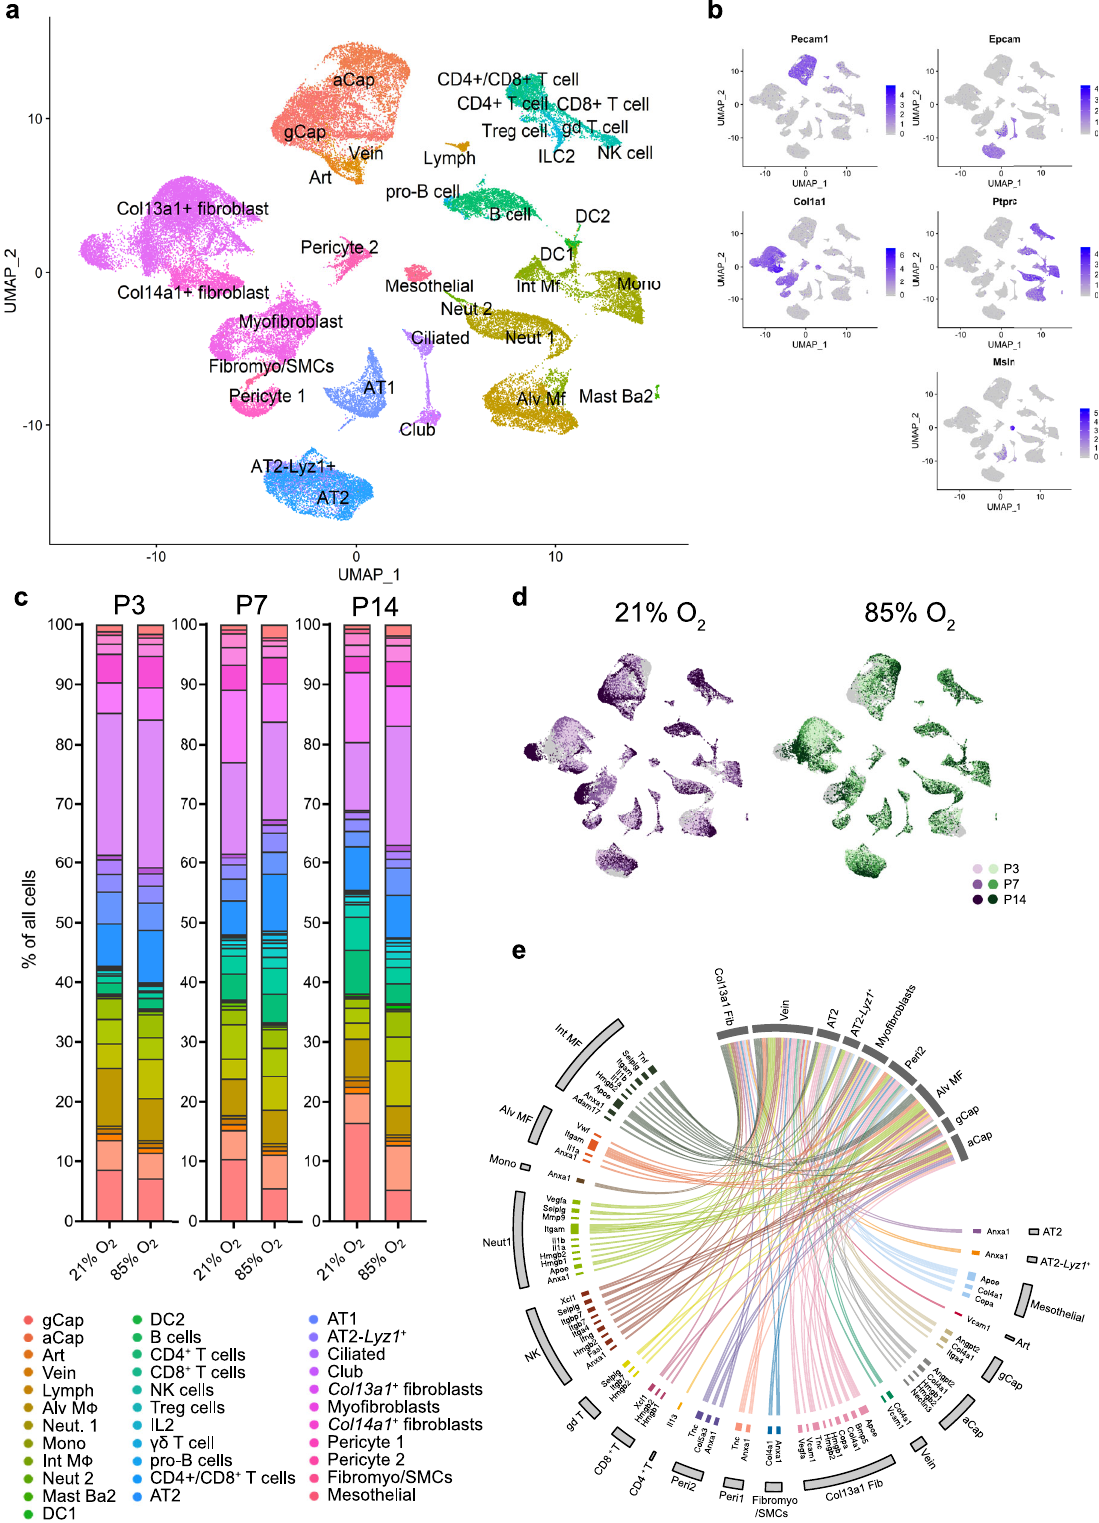
Hyperoxia induces dramatic shifts in developing murine lung stromal Col13a1 + fi broblasts, myo fi broblast, and pericyte populations . Within the stroma, we identi fi ed six populations, including pericytes, fi broblasts, and myo fi broblasts (Fig. 2a; Fig. 4a – c; Supplementary Data 6).